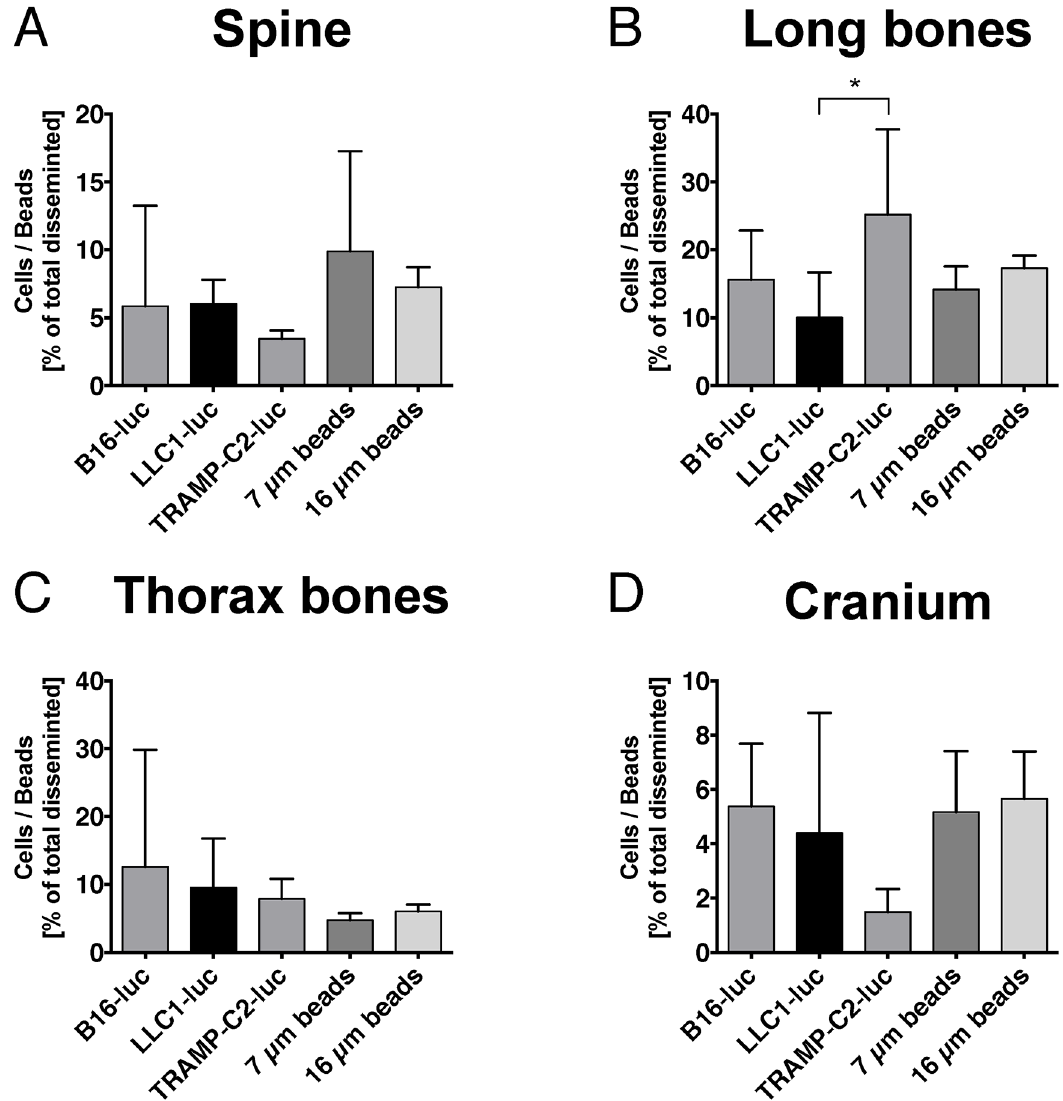
Fig 4. Comparison of B16-luc, LLC1-luc and TRAMP-C2-luc tumor cell dissemination versus microsphere dissemination (7 and 16 μ m diameter) in osseous organs. (A) Only ~5% of tumor cells and microbeads disseminated to the spine. No significant difference was found between the groups. (B) Long bones revealed dissemination fractions between ~10 – 25%. TRAMP-C2-luc disseminated significantly higher to long bones compared to LLC1-luc cells (LLC1-luc vs. TRAMP-C2-luc: p = 0.0406). No other significant dissemination differences were found. (C) Low tumor cell and microbeads dissemination was found in the thorax (~5 – 10%). No significant difference was found between the groups. (D) Dissemination to the cranium was ~2 – 6%. No significant dissemination differences were found. Mean ± SD, (B16-luc n = 4, LLC1-luc n = 5, TRAMP-C2-luc n = 5, 7 μ m beads n = 5, 16 μ m beads n = 5) for all experiments shown, one way ANOVA with Bonferroni post hoc